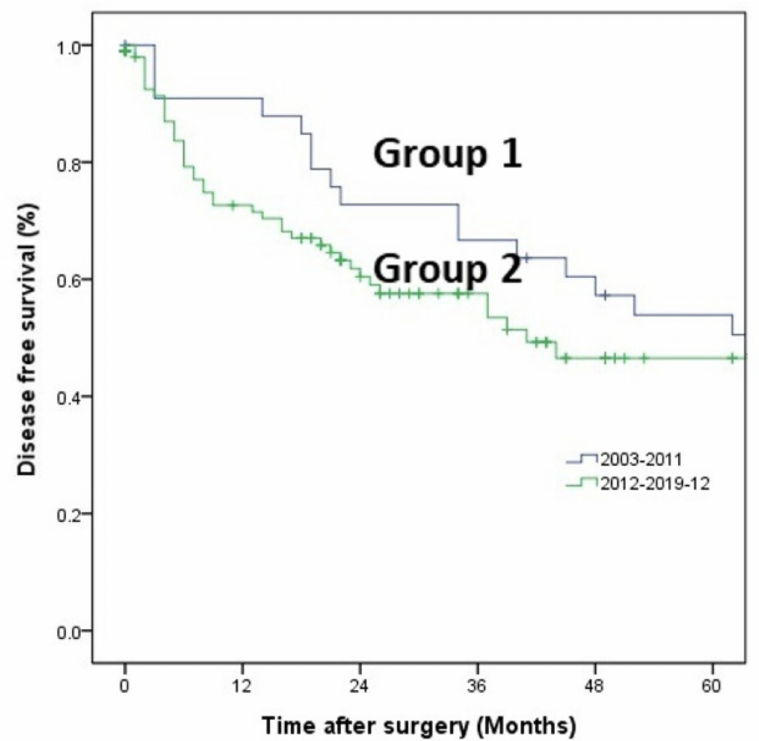
Figure 2. Disease free survival: five-year disease free survival rate in Group 1 and Group 2, case- matched